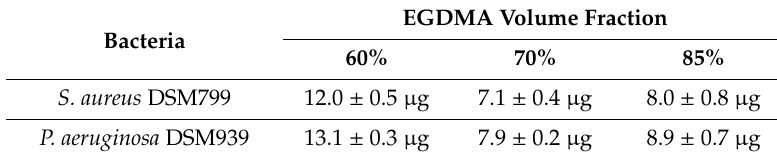
Table 2. Amount of active gentamicin released from gentamicin loaded disks against the pathogens.